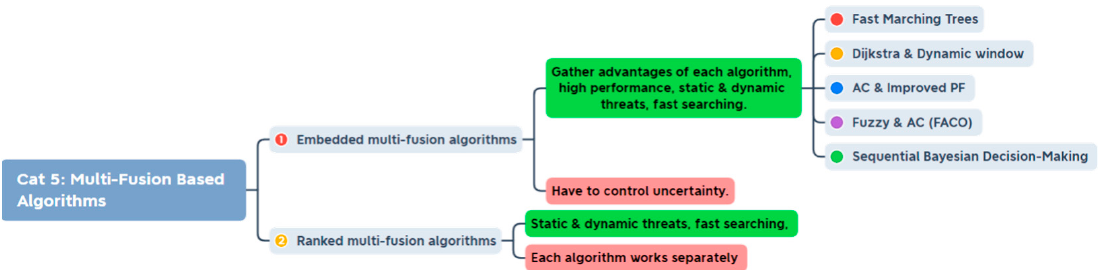
Figure 8. Multi-Fusion based algorithms with the main advantages and drawbacks.